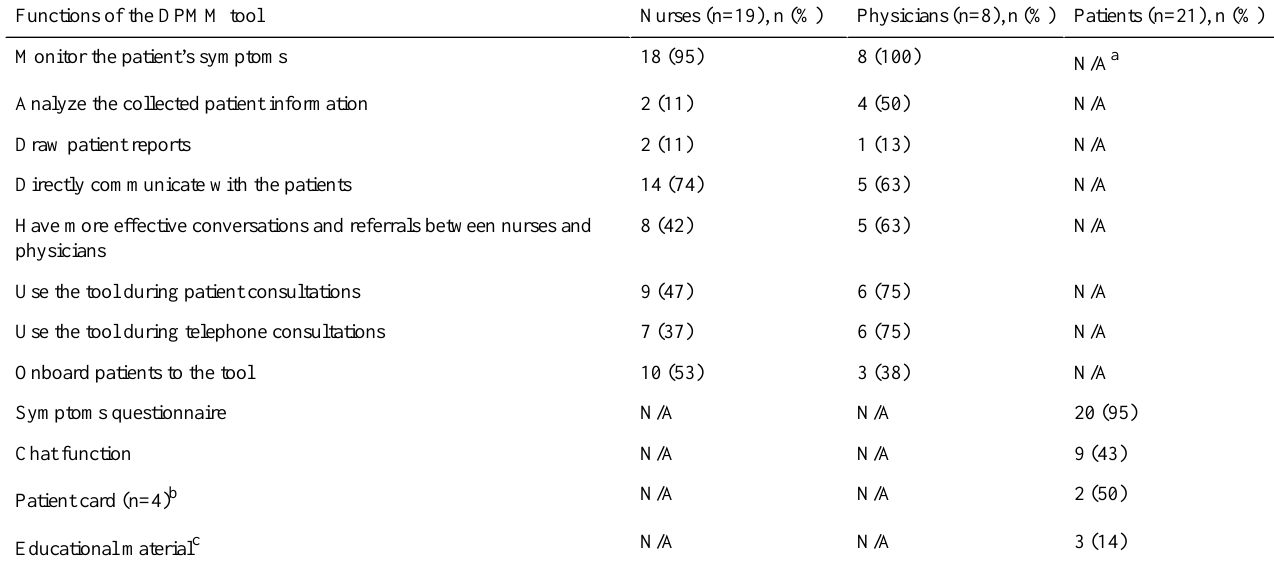
Table 7. Functions of the digital patient monitoring and management (DPMM) tool most commonly appreciated by end-of-study survey